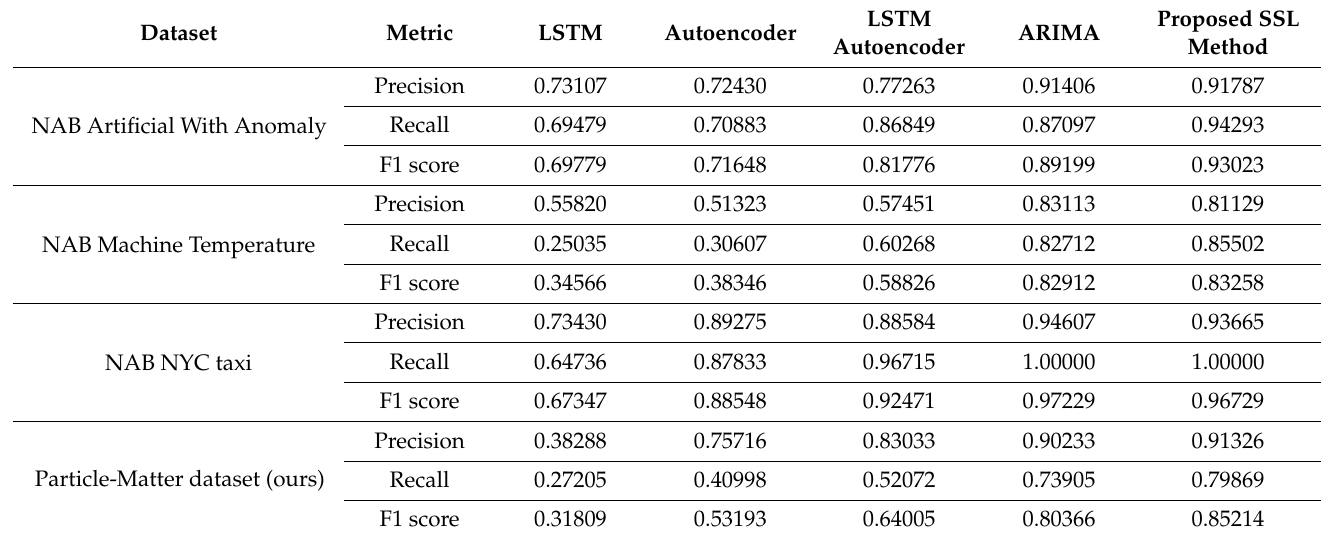
Table 3. Comparison of the proposed framework using SSL and other